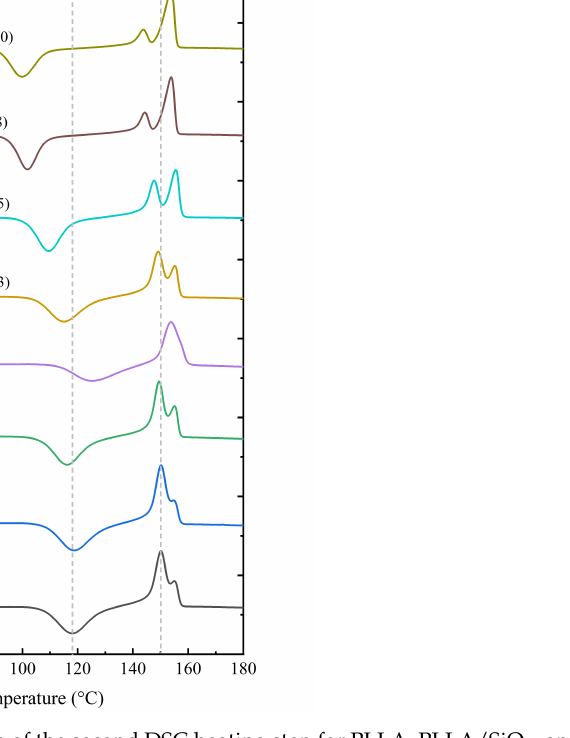
Figure 3. Thermogram of the second DSC heating step for PLLA, PLLA/SiO 2 , and PLLA/SiO 2